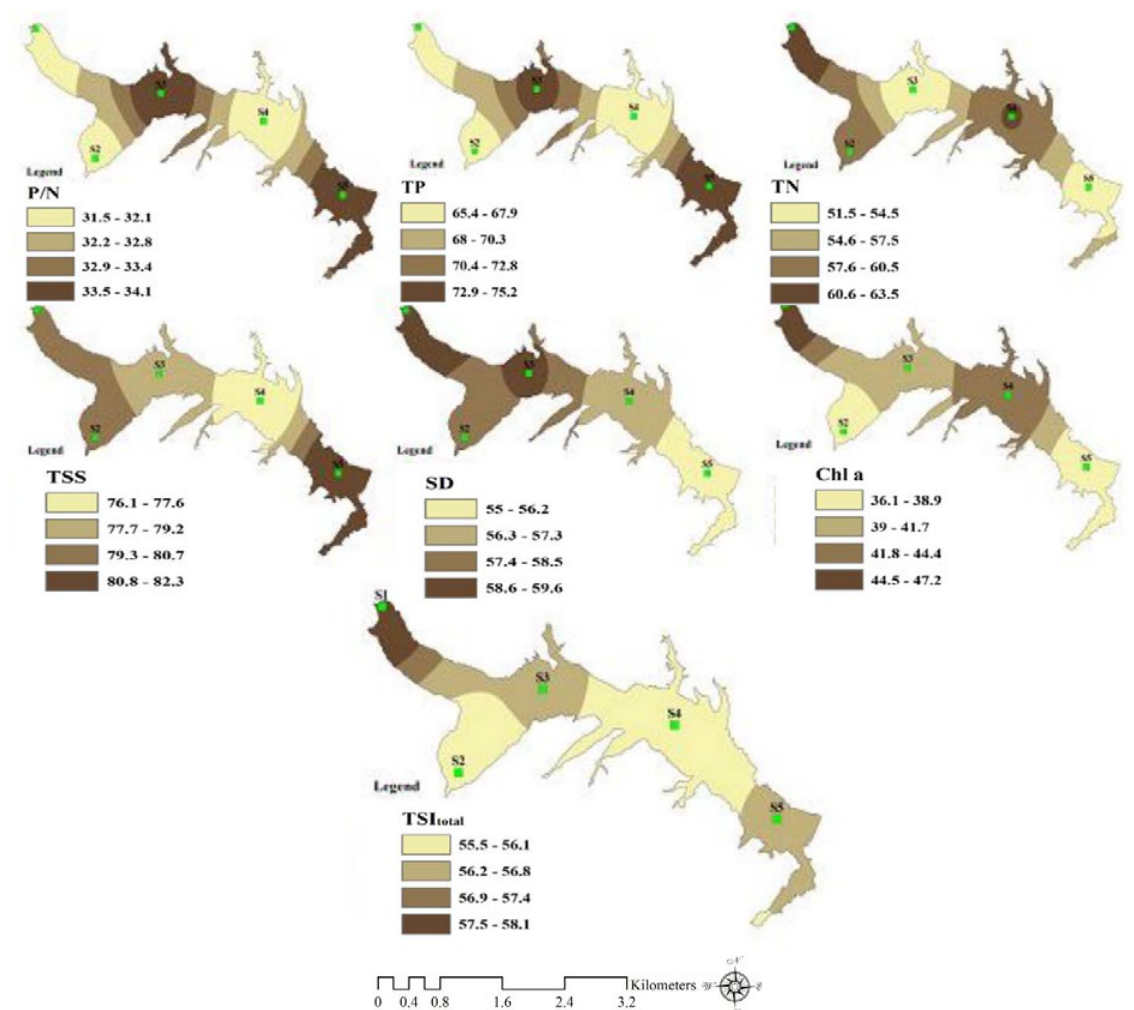
Fig. 5: Spatial distribution of the TSI index for individual parameters and total eutrophication index